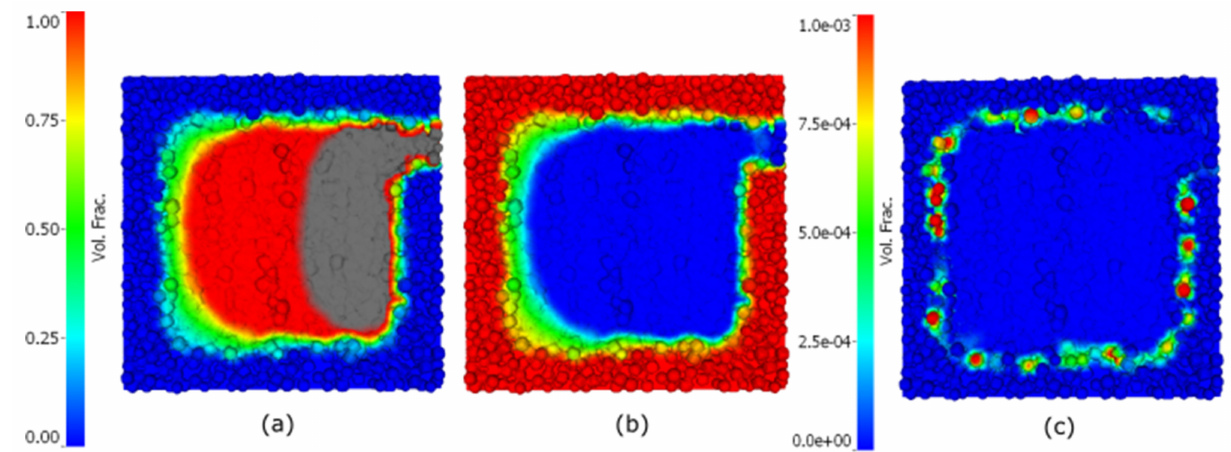
Figure 8. Volume fractions of microstructure phases of the powder bed at time t = 0.014 s ( a ) β ; ( b ) α ms ; ( c ) α wid . The grey section in the β plot denotes the melted Ti-6Al-4V state.